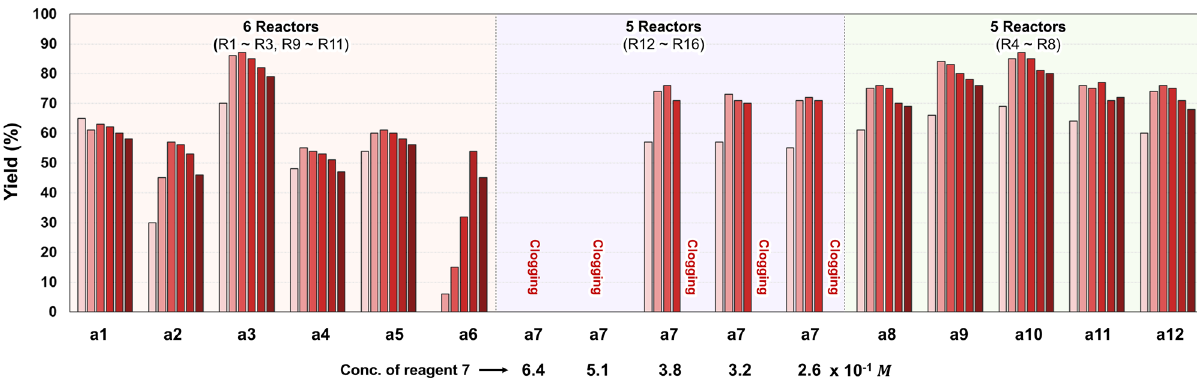
Fig. 5 Screening 96 conditions at 16 reactors by 6 sequences at different reaction times. Screening of reaction variables in reaction time (30 – 900 s) and concentration using a fl ow parallel synthesizer to fi nd the optimal conditions of aryl diazonium-based chemical library. The red boxed region represents the syntheses based on substitution of nucleophilic aromatics, the purple boxed region represents azo-coupling of carbocycles and the green boxed region represents azo-coupling